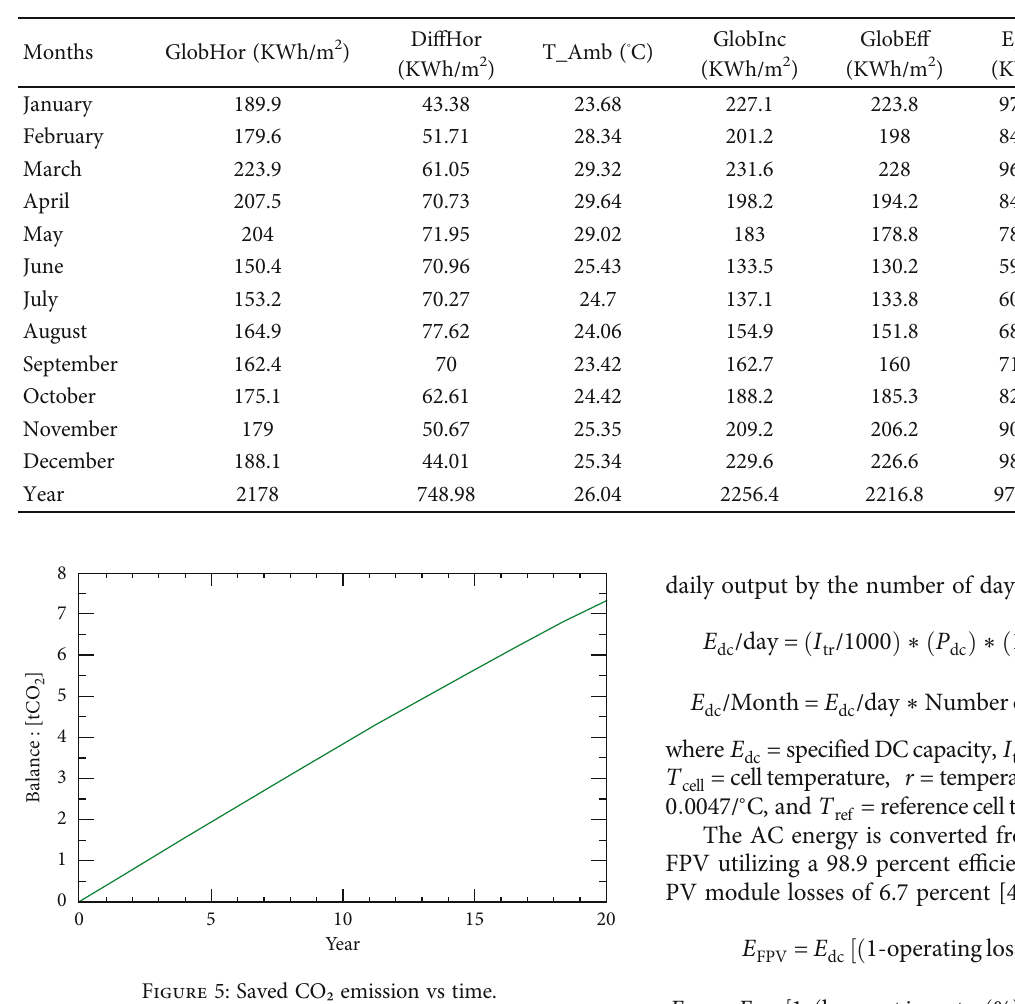
Table 5: Monthly based di ff erent parameters estimation using PVsyst.